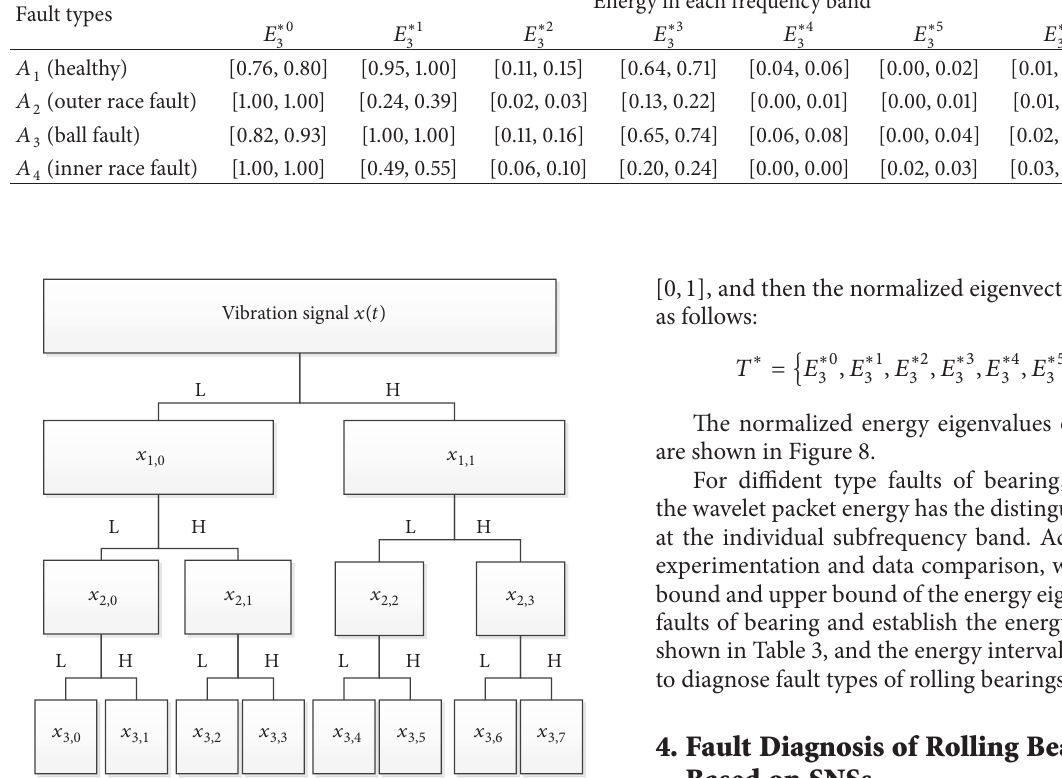
Figure 7: Diagram of 3-level wavelet packet decomposition (L: low- pass filter, H: high-pass